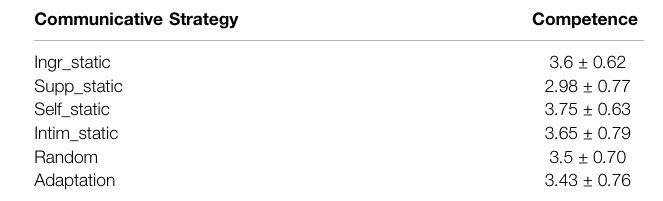
TABLE 2 | Mean and standard deviation values of warmth scores for each level of CommunicativeStrategy.Themean scoreforIntim_staticissigni fi cantlylower than that for all the other conditions.